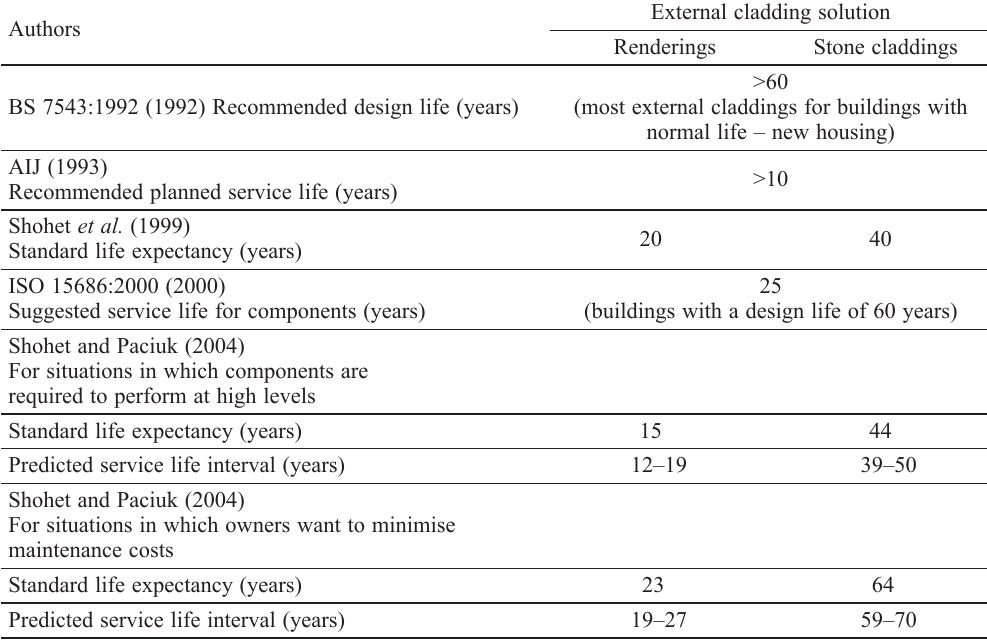
table 1. reference service life proposed by different authors and normative